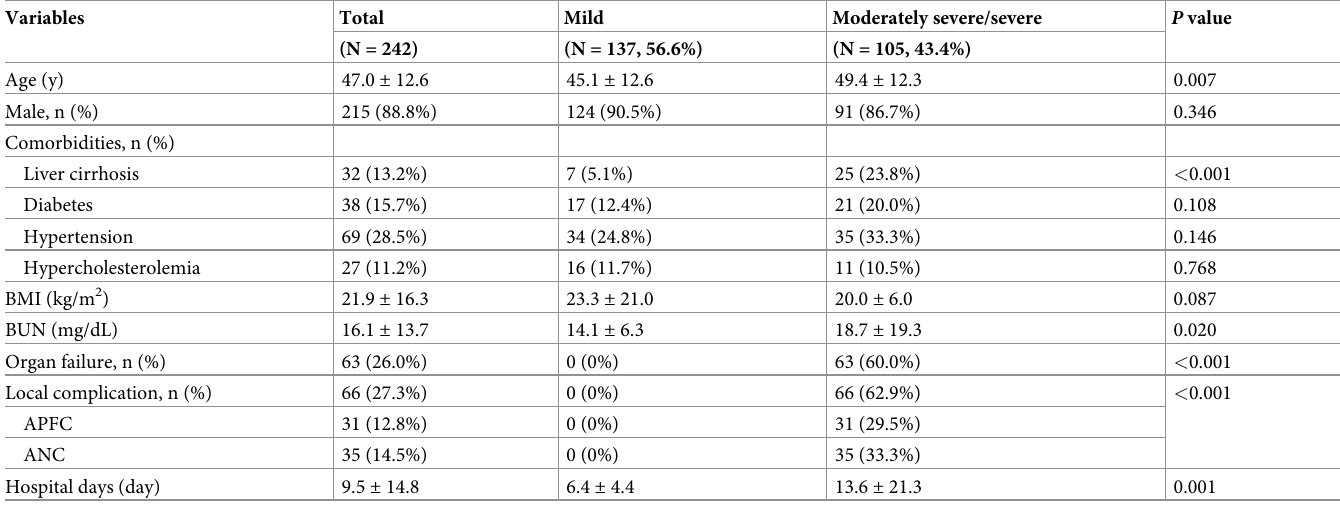
Table 1. Patient baseline characteristics (N = 242).